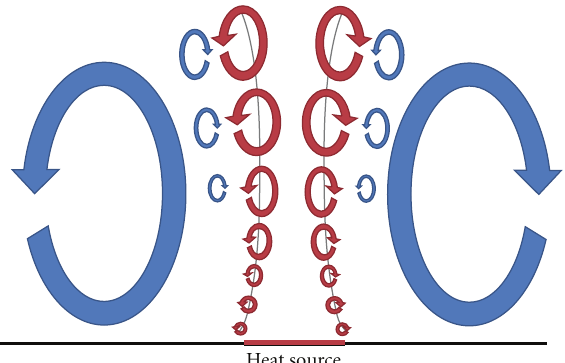
Figure 1: Vertical cross-section through idealized fire illustrating occurrence of vortices due to horizontal gradient of vertical motion produced by buoyancy from the